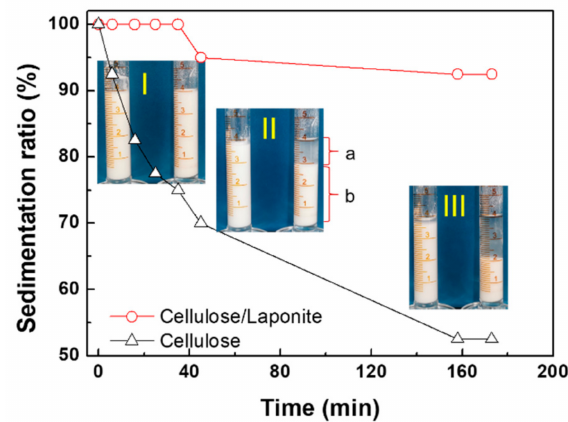
Figure 9. Sedimentation ratio of the two ER fluids as a function of time. Insets are the optical images of the ER fluids contained in glass tubes (left: cellulose ER fluid; right: cellulose/Laponite ER